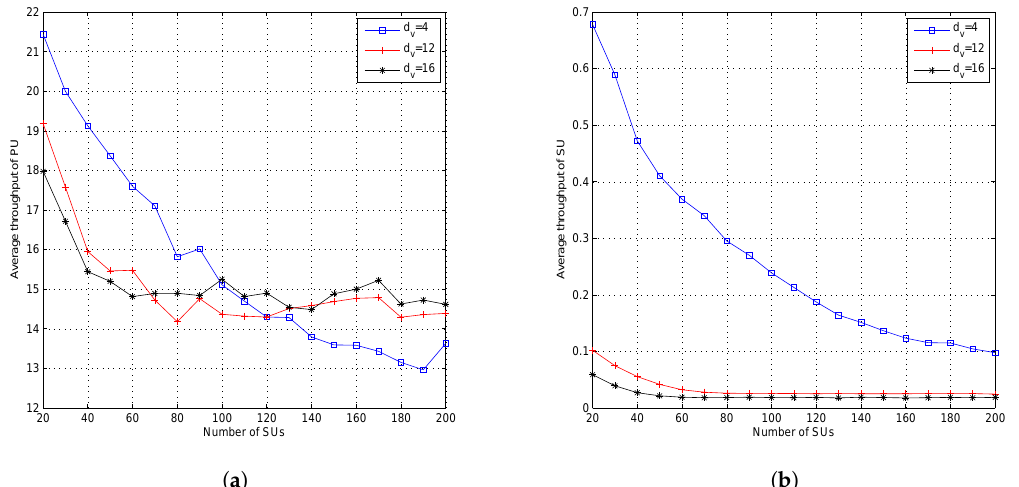
Figure 12. Performance of the proposed algorithm with variation of the value of d v and fixed d c ( d c = 9); ( a ) throughput of SUs and ( b ) throughput fairness